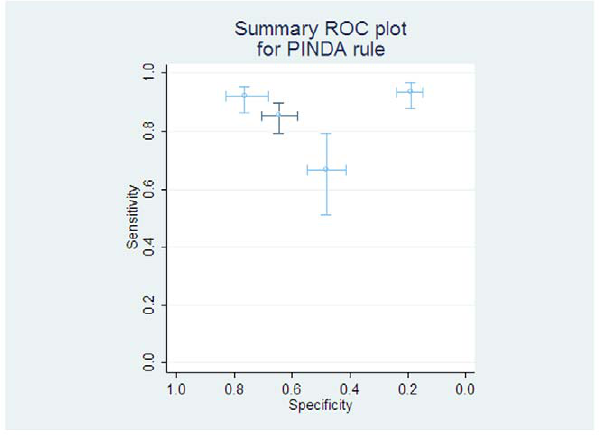
Figure 5. Individual and pooled diagnostic test accuracy of ‘PINDA’ rule. The light lines and circles represent individual studies, with the darker dashed lines showing the study from which the rule was